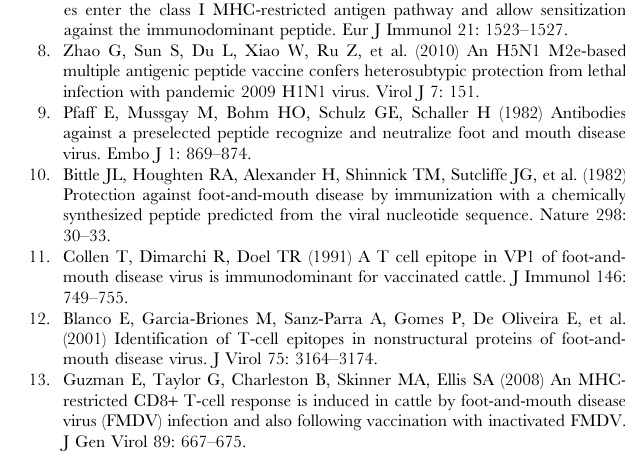
Table S1 Searching FMDV/VP1-28-34 and FMDV/VP1- 157-165 in Protein databank(PDB) by blast.